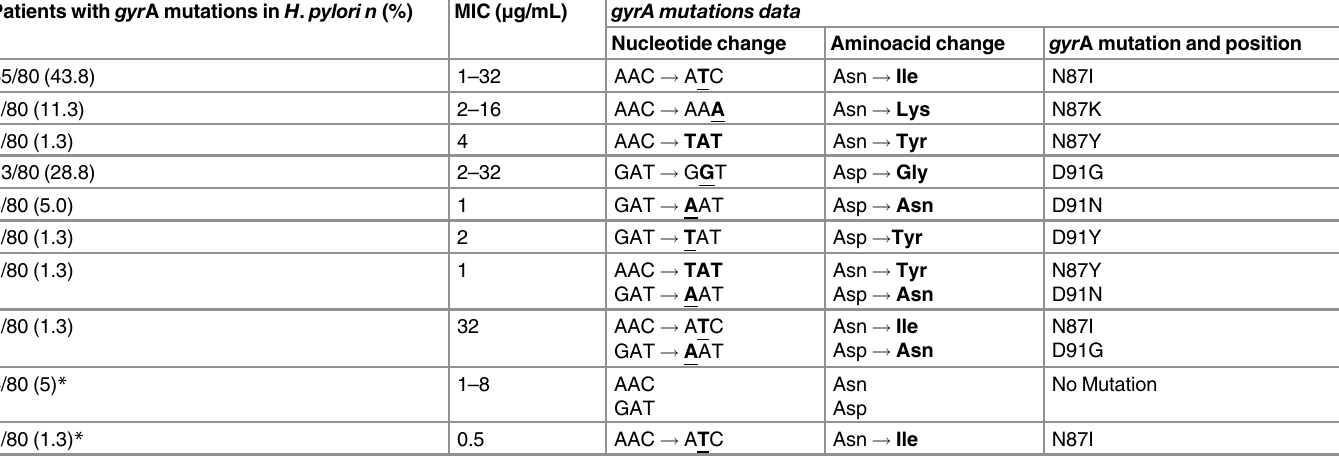
Table 1. Association between minimal inhibitory concentrations levels (MICs) and gyrA nucleotides substitution and types of mutations in gyr A QRDR. Patients with gyr A mutations in H . pylori n (%) MIC ( μ g/mL) gyrA mutations data Nucleotide change Aminoacid